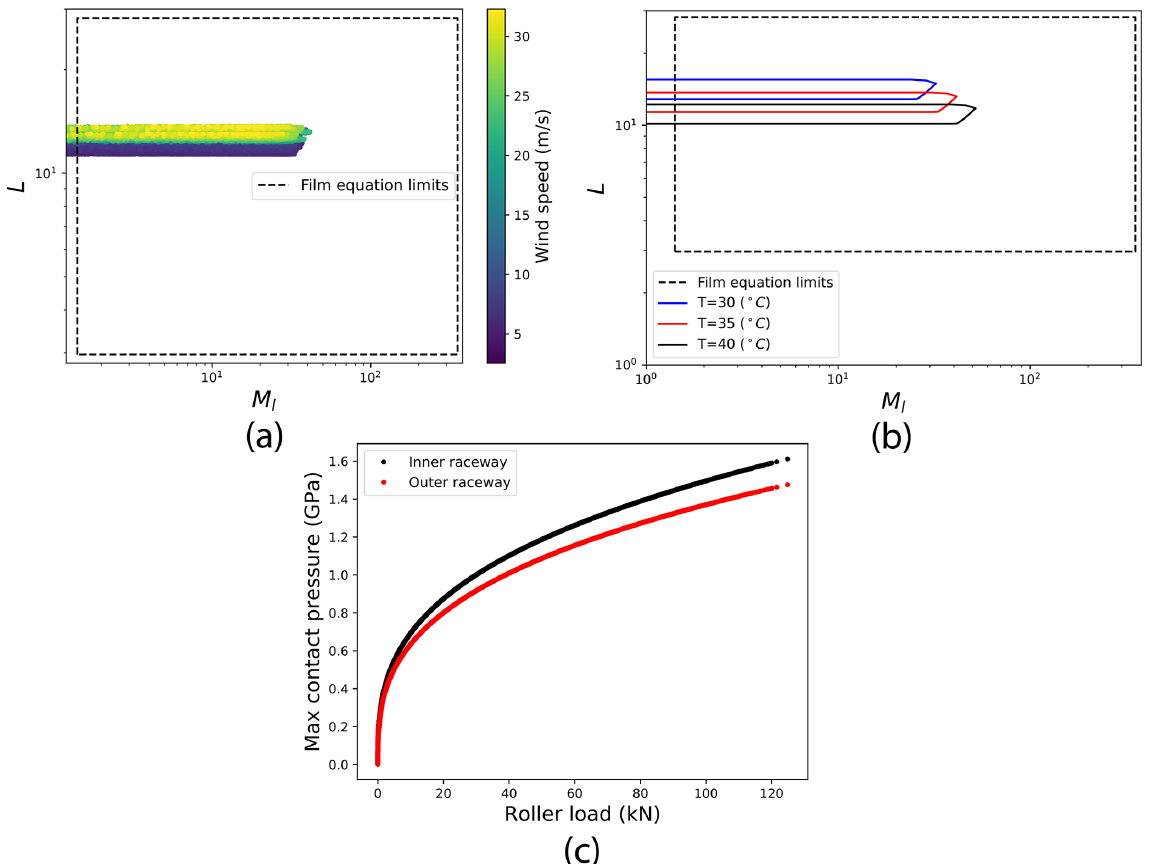
Figure 2. Lubrication conditions, in the form of dimensionless parameter values and maximum Hertzian pressures within contact conjunc- tions. Panel (a) shows dimensionless parameter results at 35 ◦ C for both inner and outer raceways; (b) the contact condition point boundaries for temperatures of 30, 35 and 40 ◦ C; and (c) the maximum contact pressures from across the